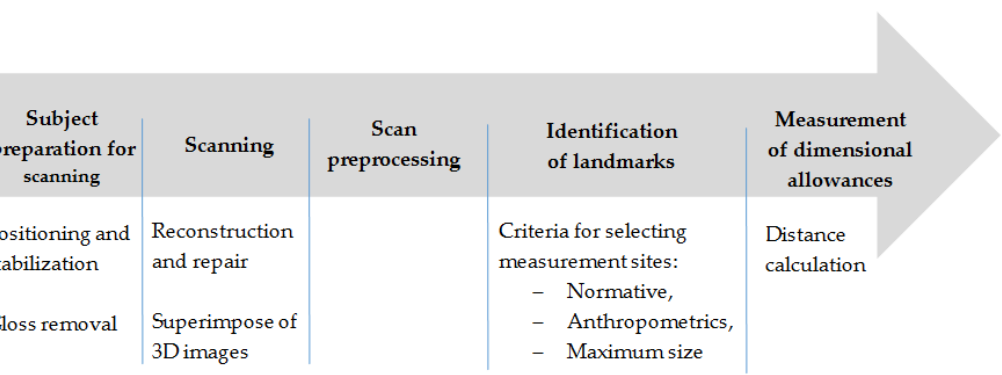
Figure 4. Flowchart of procedure for determining dimensional allowances for PPE using CloudCompare software.